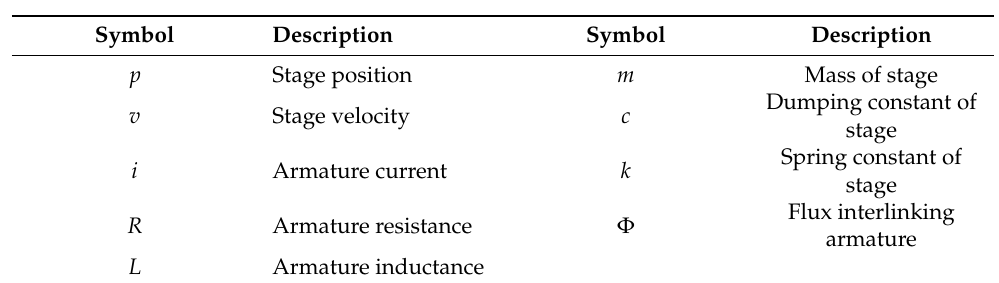
Table 1. Symbols of linear